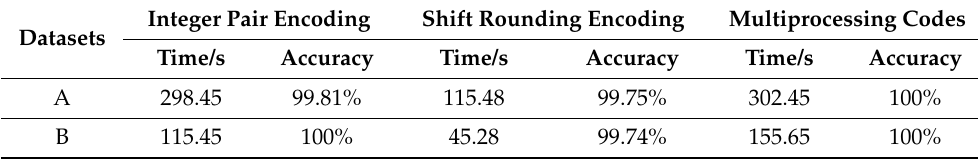
Table 1. Time overhead and accuracy of different coding